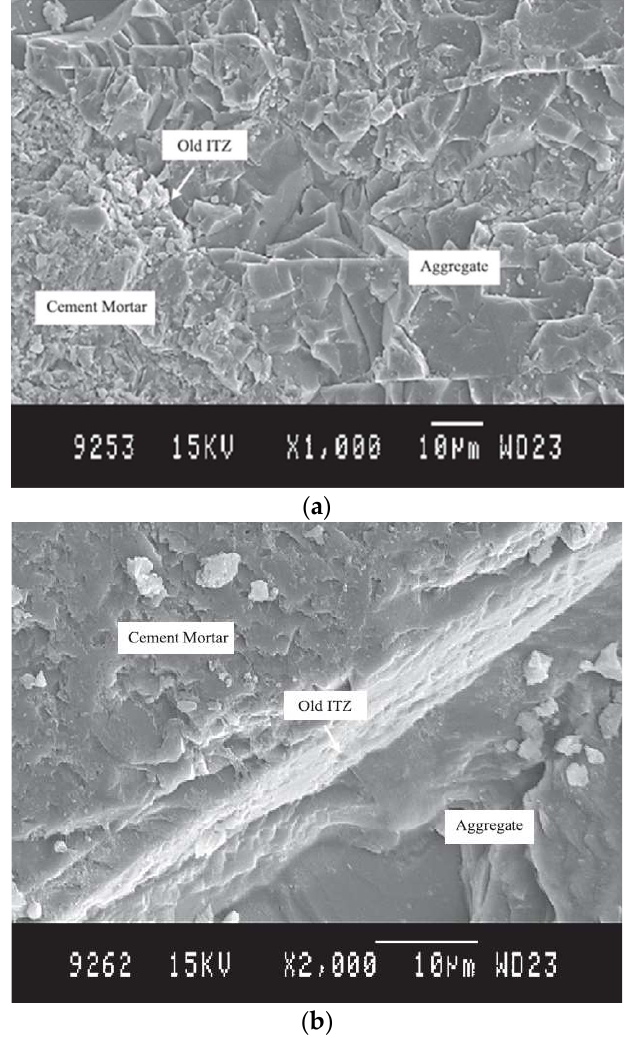
Figure 10. SEM images of old ITZ after ( a ) TSMA; ( b ) normal mixing [42]. Reproduced with per- mission from [42], Elsevier, 2005.